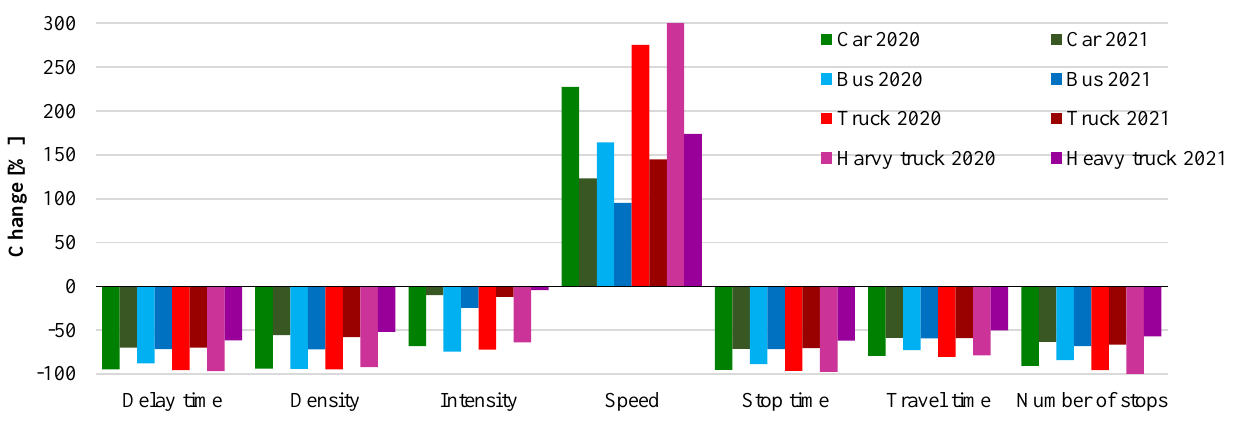
Figure 6. Changes in monitored characteristics compared to 2019 for individual vehicle categories.